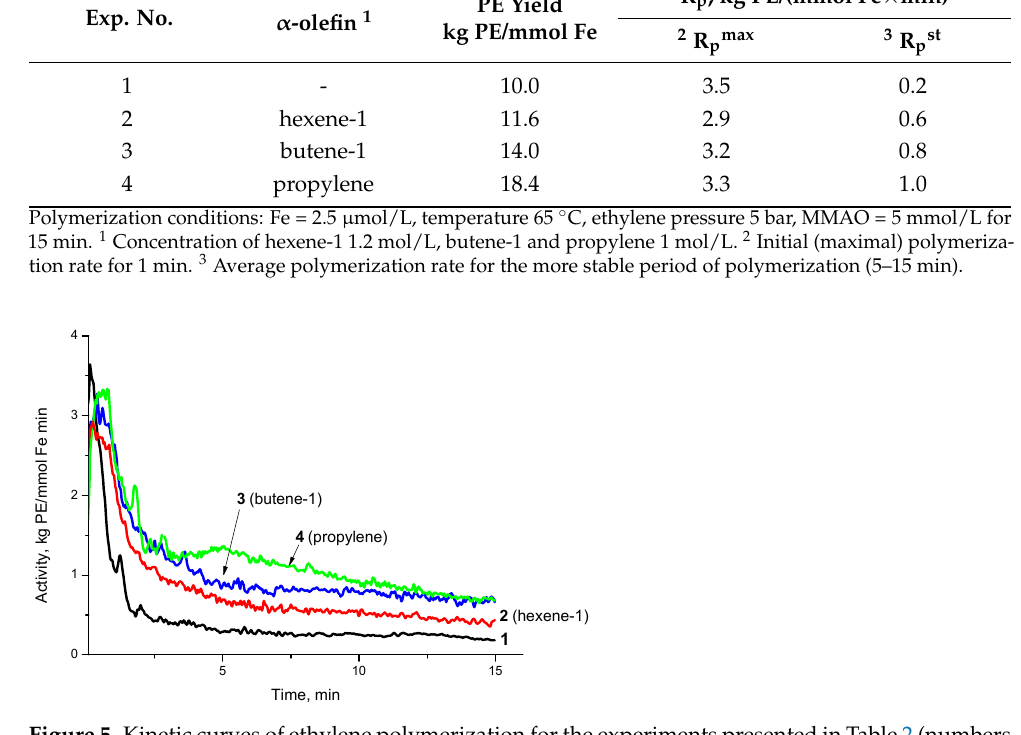
Figure 5. Kinetic curves of ethylene polymerization for the experiments presented in Table 2 (numbers of the curves correspond to the experiment numbers in Table 2).